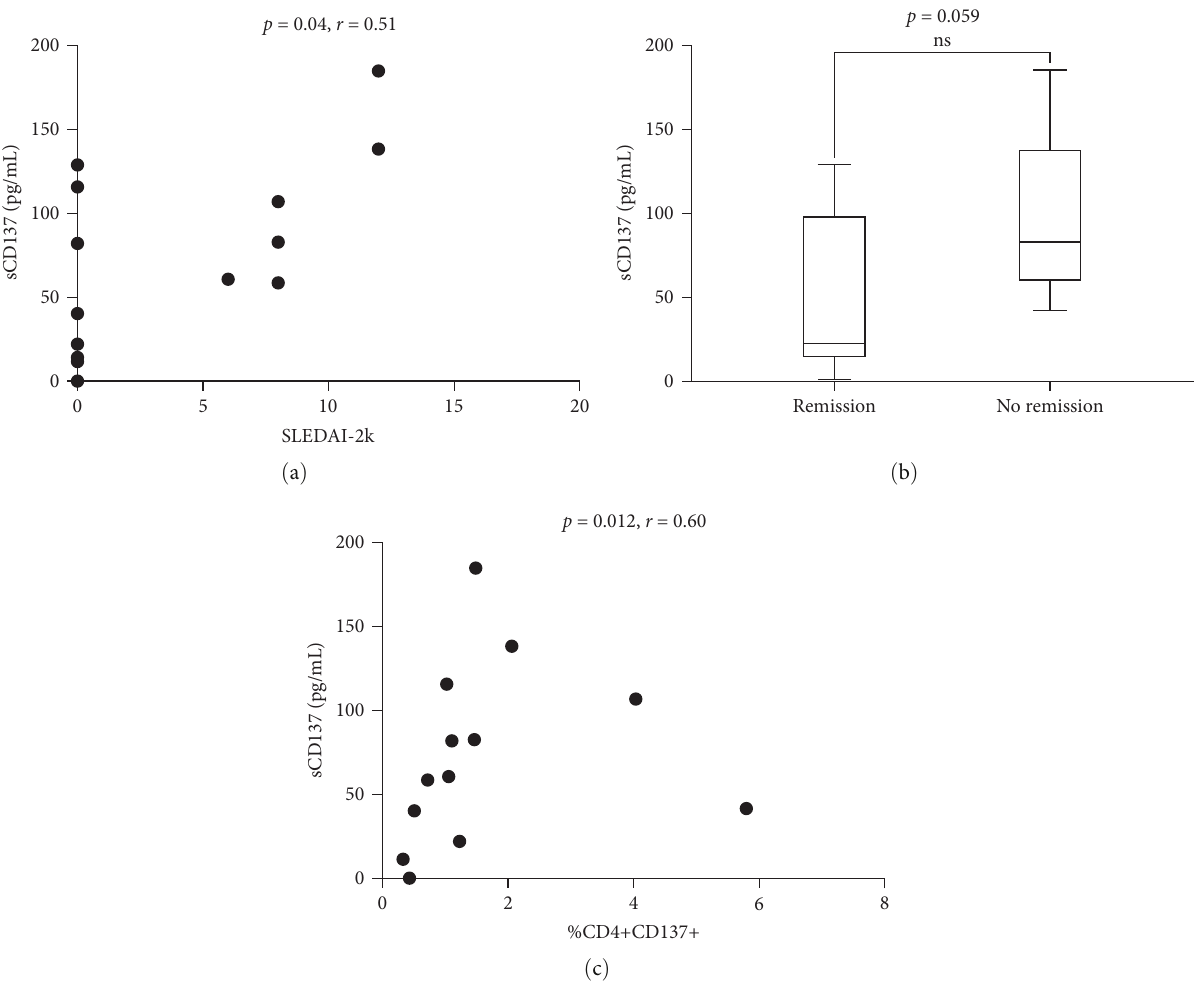
F IGURE 2: (a) Correlation between sCD137 serum levels and SLEDAI-2K; (b) comparison of sCD137 in SLE patients according to remission status; (c) correlation between sCD137 levels and %